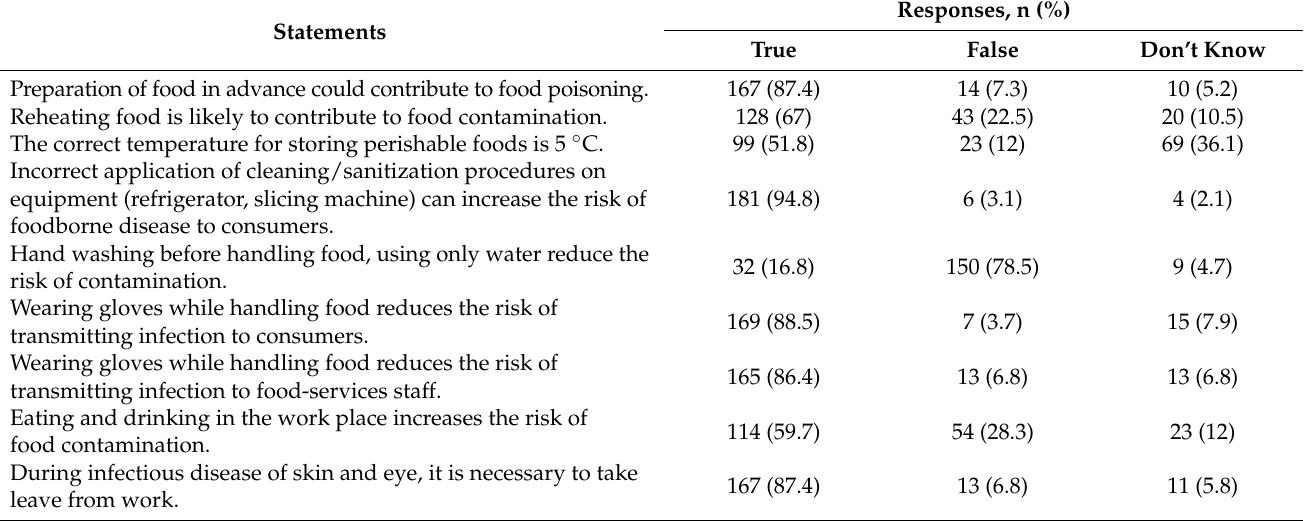
Table 2. Summary of questions and responses for assessment of food safety knowledge of food handlers working at hospitals in Bangladesh (N =